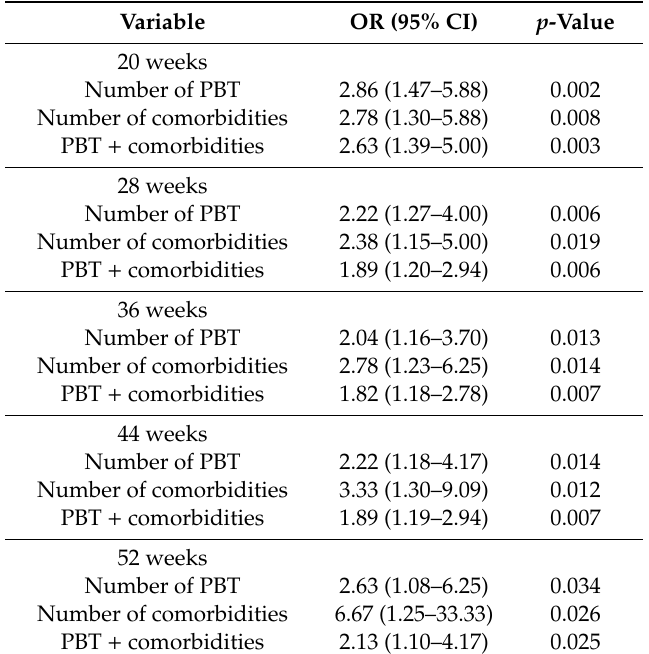
Table 4. Univariate logistic regression analysis of variables associated with PASI 100